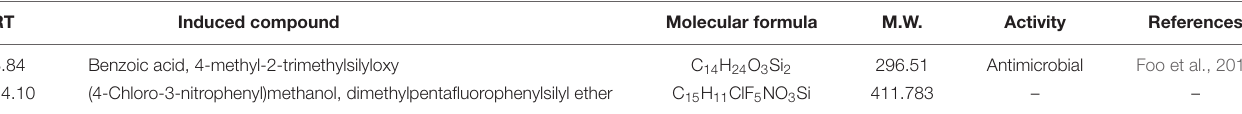
TABLE 3 | Induced compound in D. longicolla culture treated with 100 nM BRD4770. RT Induced compound Molecular formula